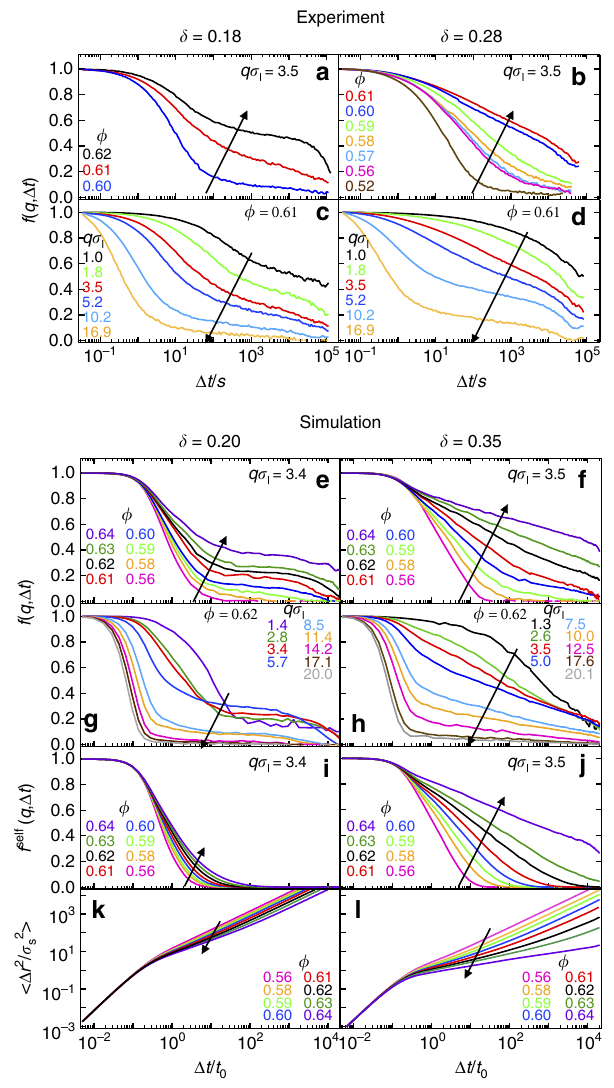
Figure 2 | Dynamics of the intruders as observed in experiments and simulations. Collective f ( q , D t ) ( a – h ) and self f self ( q , D t ) ( i – j ) intermediate scattering functions and mean-squared displacements D r 2 = s 2 function of delay time D t , describing the dynamics of small spheres in binary mixtures with size ratios d below (left) and around (right) the onset of anomalous dynamics, for different magnitudes of the scattering vector q and total volume fraction f (as indicated). Arrows indicate increasing f and increasing q